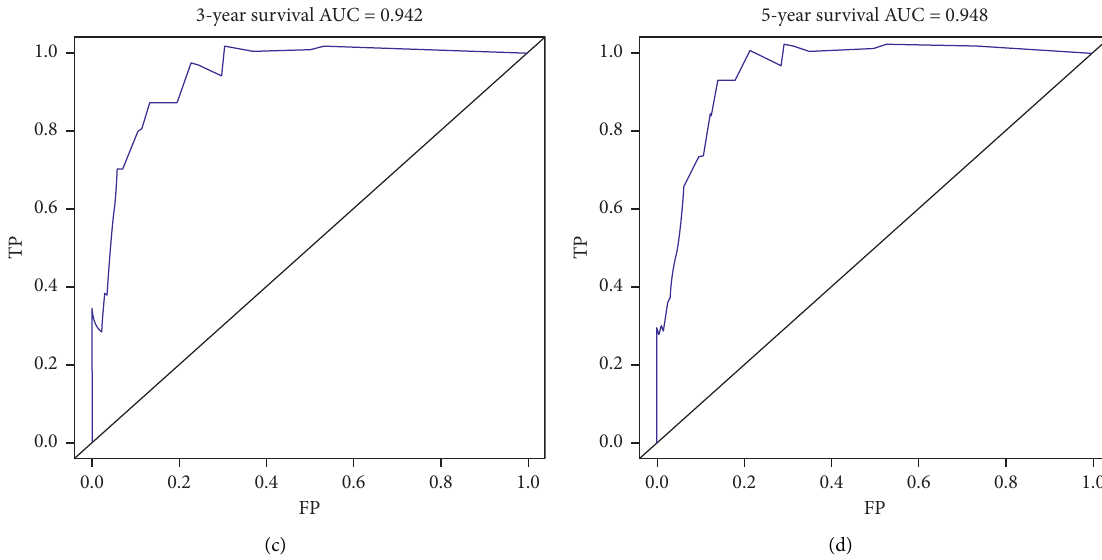
Figure 6: Receiver operating characteristic curves (ROC) for evaluating the performance of predicting 3-year (a) and 5-year (b) overall survival and 3-year (c) and 5-year (d) cancer-specific survival in the test